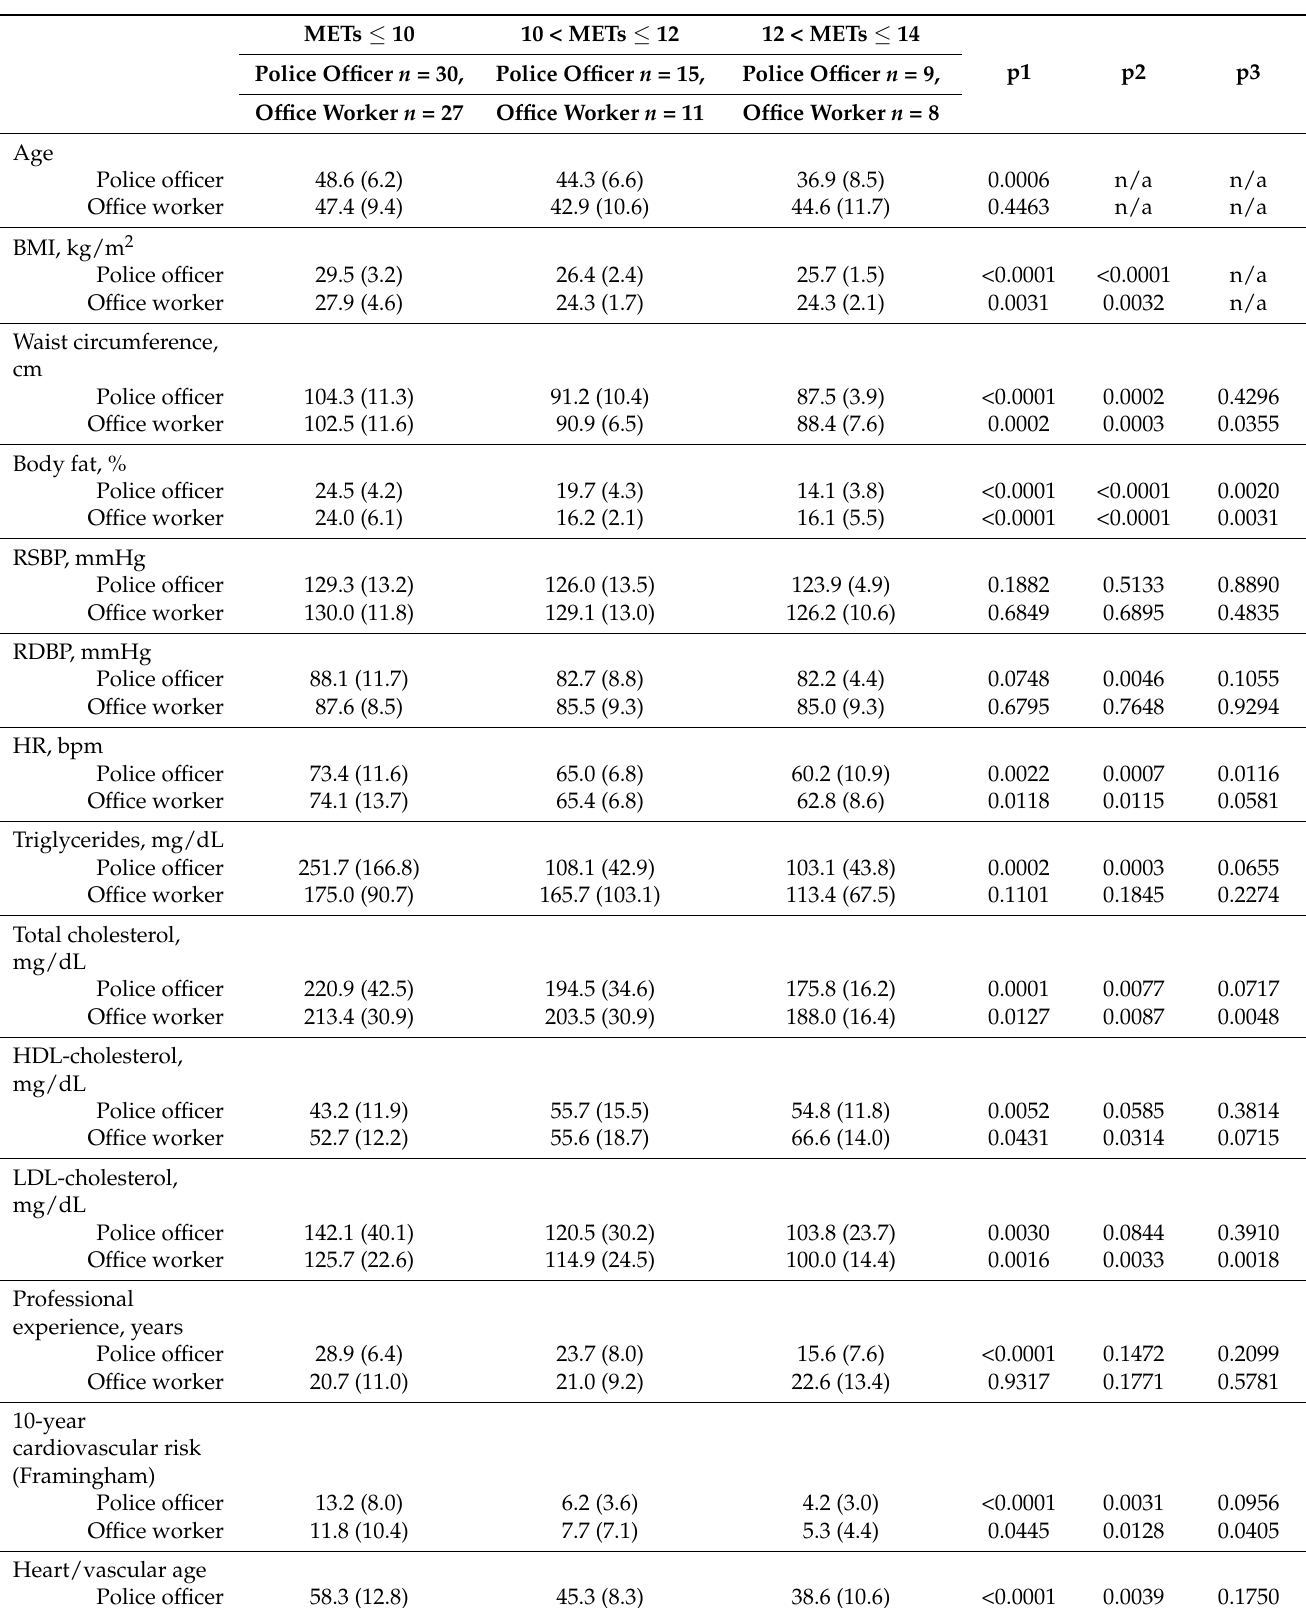
Table 2. Cardiovascular risk factors of each MET category among police officers and office